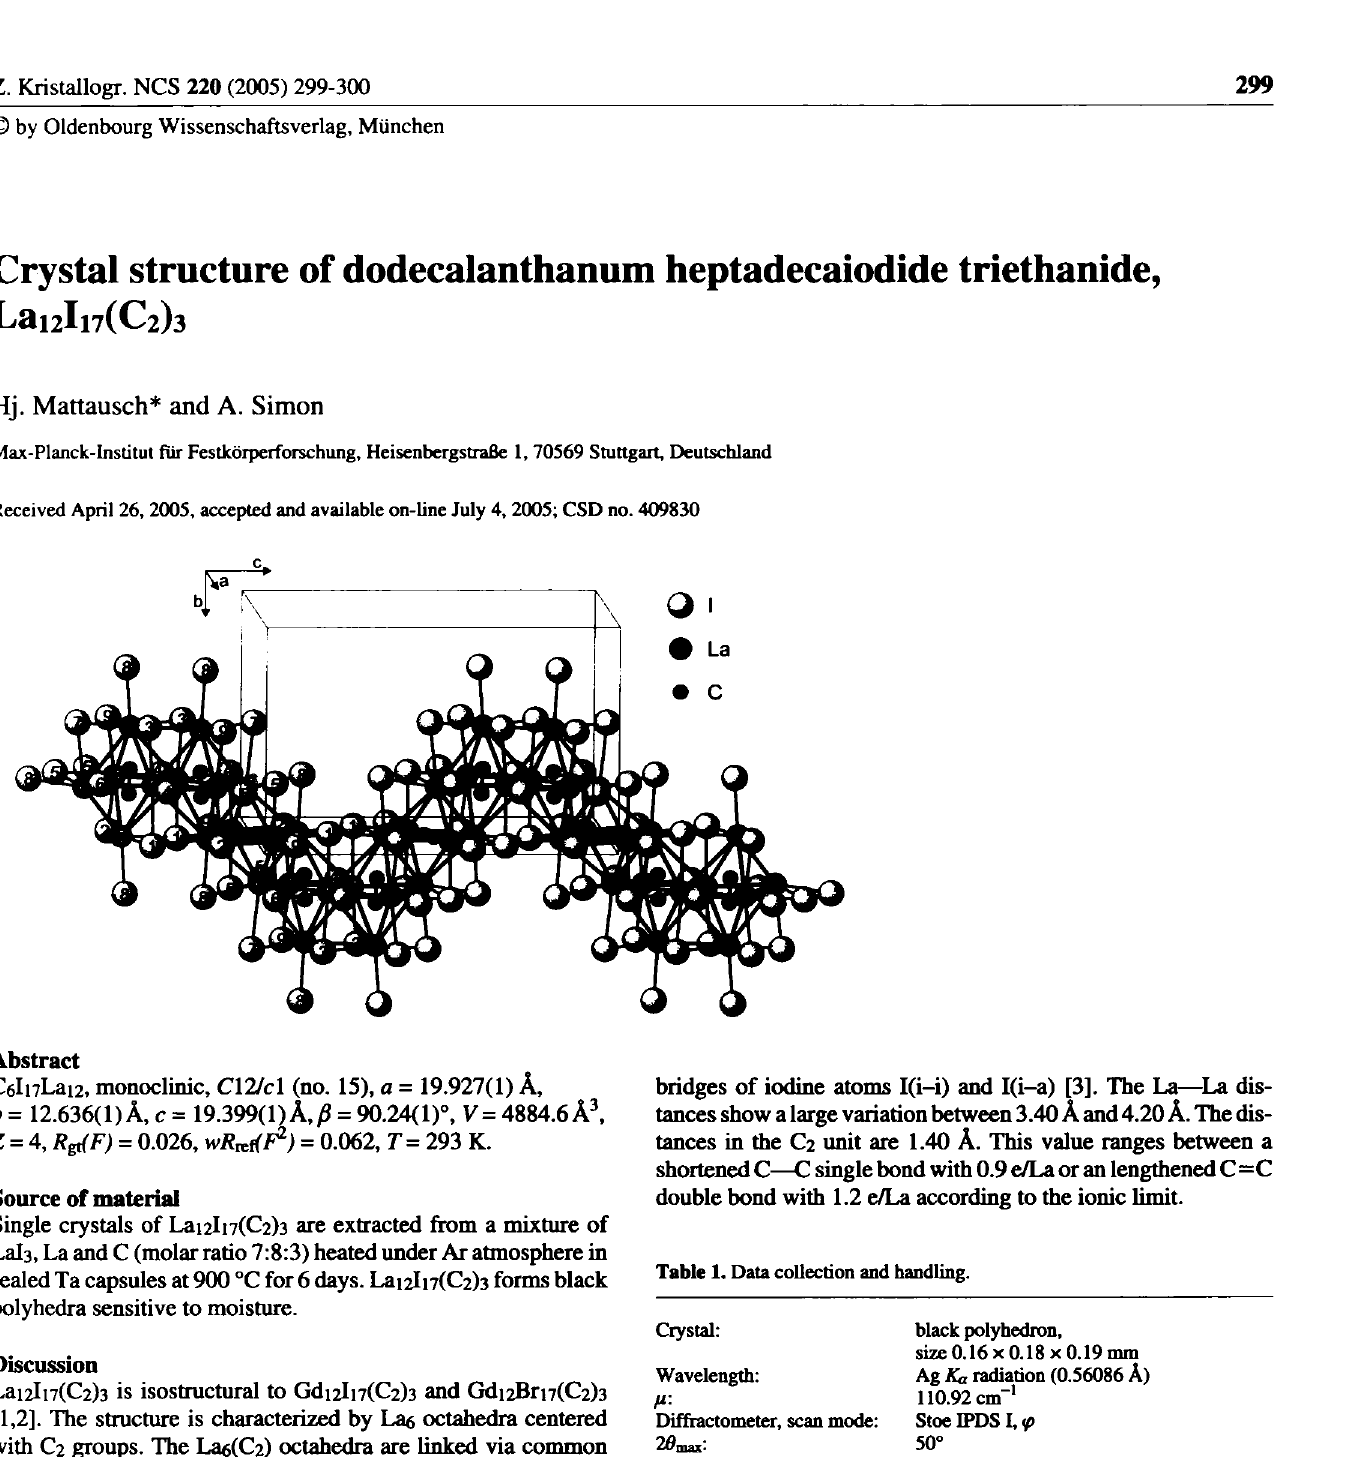
Table 1. Data collection and handling. Crystal: